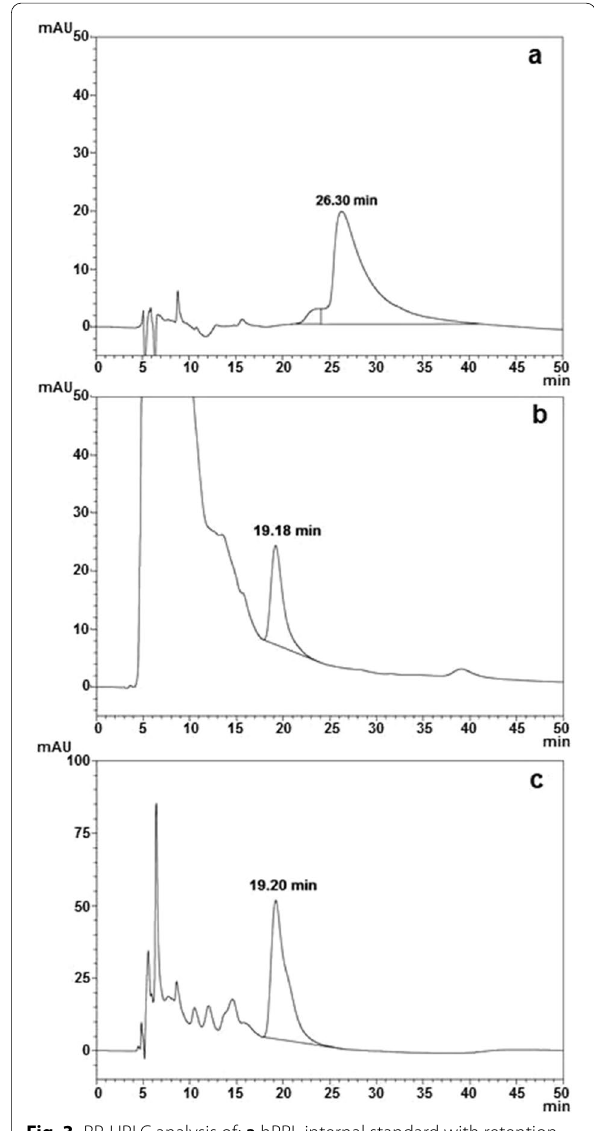
Fig. 3 RP-HPLC analysis of: a hPRL internal standard with retention time (t R ) of 26.30 min; b Δ 1-11 -G129R-hPRL, before purification from periplasmic fluid, with t R of 19.18 min; c Δ 1-11 -G129R-hPRL after the two-step purification process, with t R 19.20. A C4 Vydac 214TP54 = column (25 cm 4.6 mm ID) was used. The mobile phase consisted × of 71% 50 mM Tris–HCl buffer, pH 7.5, and 29% n-propanol, with a flow rate of 0.5 ml/min, column temperature maintained at 45 °C, monitoring at 220 nm and applying a sample volume of 10 µL ( a ) or 100 µL ( b, c